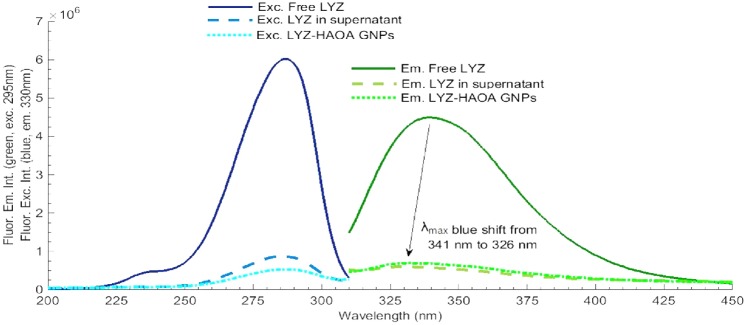
Conjugation effect: LYZ in supernatant (after conjugation) compared with free LYZ and LYZ-conjugated HAOA gold nanoparticles (GNPs).Fluorescence excitation spectra was fixed at 330 nm and fluorescence emission spectra was fixed at 295 nm. Experiments were conducted at 20°C and excitation slit size fixed at 2.0 mm (4.4 μW). LYZ was not continuously excited and only the necessary UV light was used for obtaining the displayed spectra.